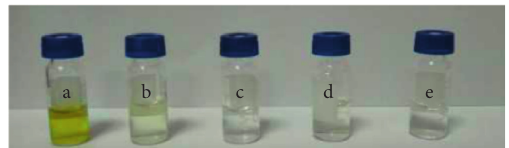
Figure 2: Different amounts of black carbon removal effect: 0mg